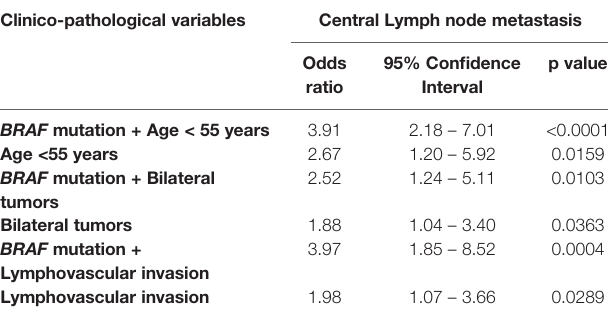
TABLE 4 | Combination of BRAF mutation and other risk factors as predictors of central lymph node metastasis. Clinico-pathological variables